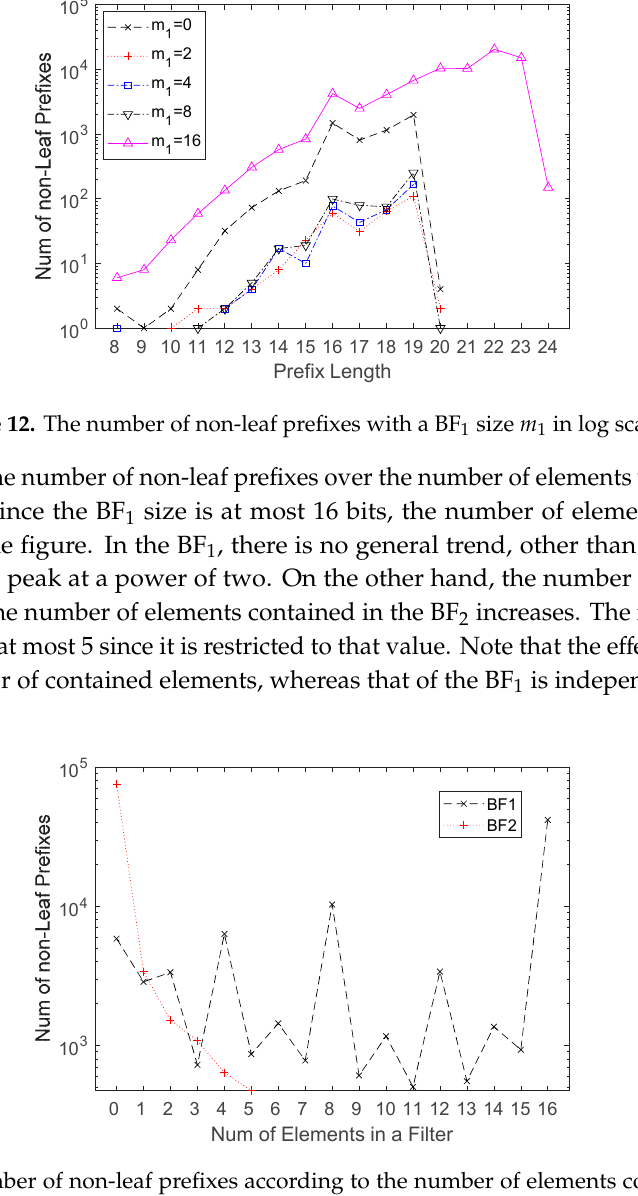
Figure 13. The number of non-leaf prefixes according to the number of elements contained in their filters in log scale.